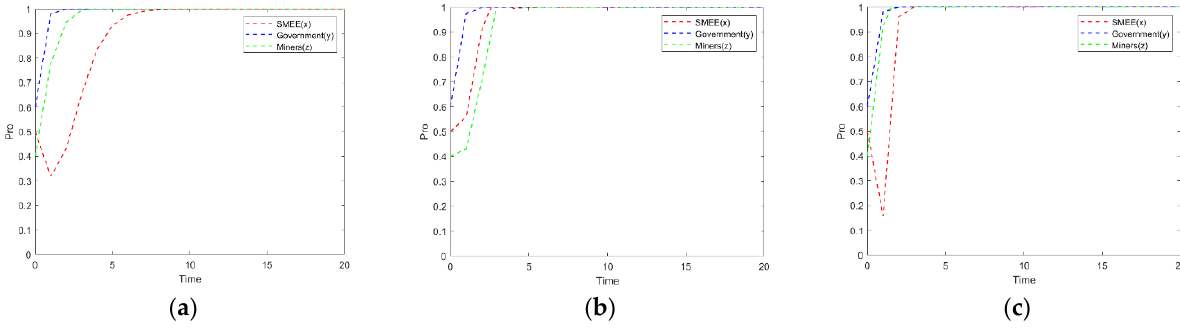
Figure 4. C a = 5 , strategy evolution process of the three game subjects under 3 emotional states of the miner. ( a ) 𝑟 1 = 𝑟 2 = 𝑟 3 = 1 ; ( b ) 𝑟 3 < 1 , 𝑟 1 = 𝑟 2 = 1 ; ( c ) 𝑟 3 > 1 , 𝑟 1 = 𝑟 2 = 1 .